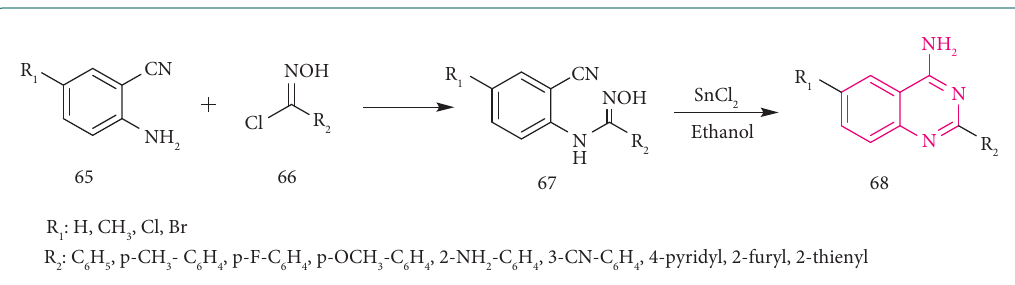
Scheme 11: Synthesis of 4-amino-2-aryl quinazoline derivatives using SnCl